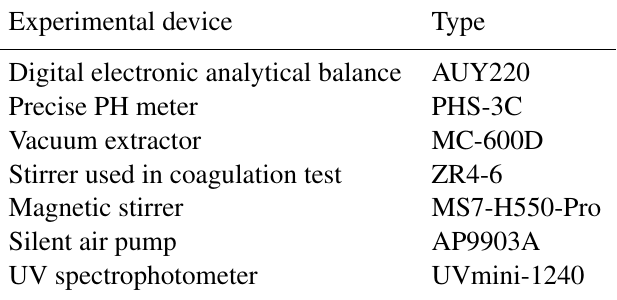
Table 1 Main instrument table for